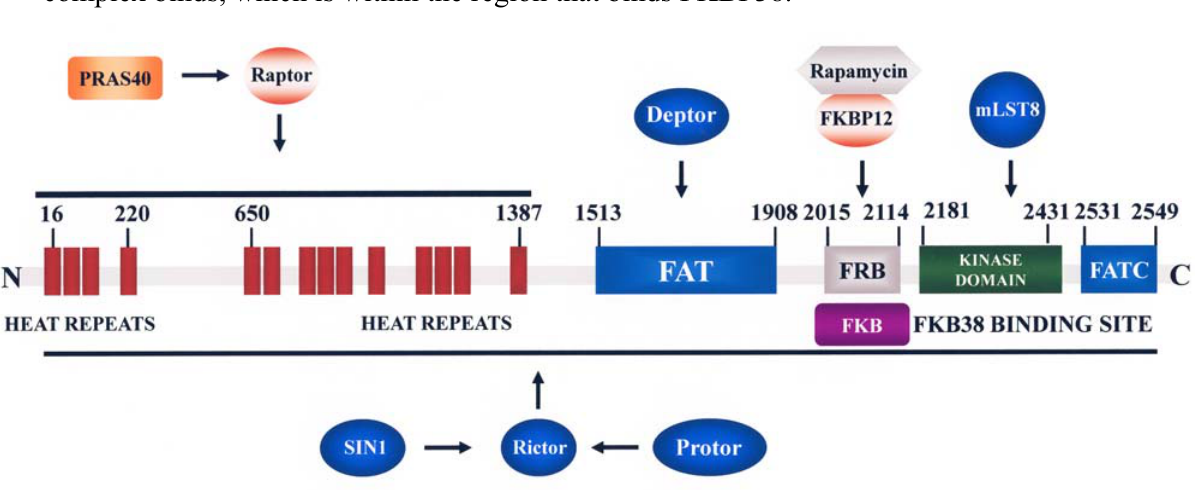
Figure 2. A schematic of mTOR structure. Some of the proteins interacting with mTOR domains are highlighted. The FRB domain is where the FKBP12 and rapamycin/rapalog complex binds, which is within the region that binds